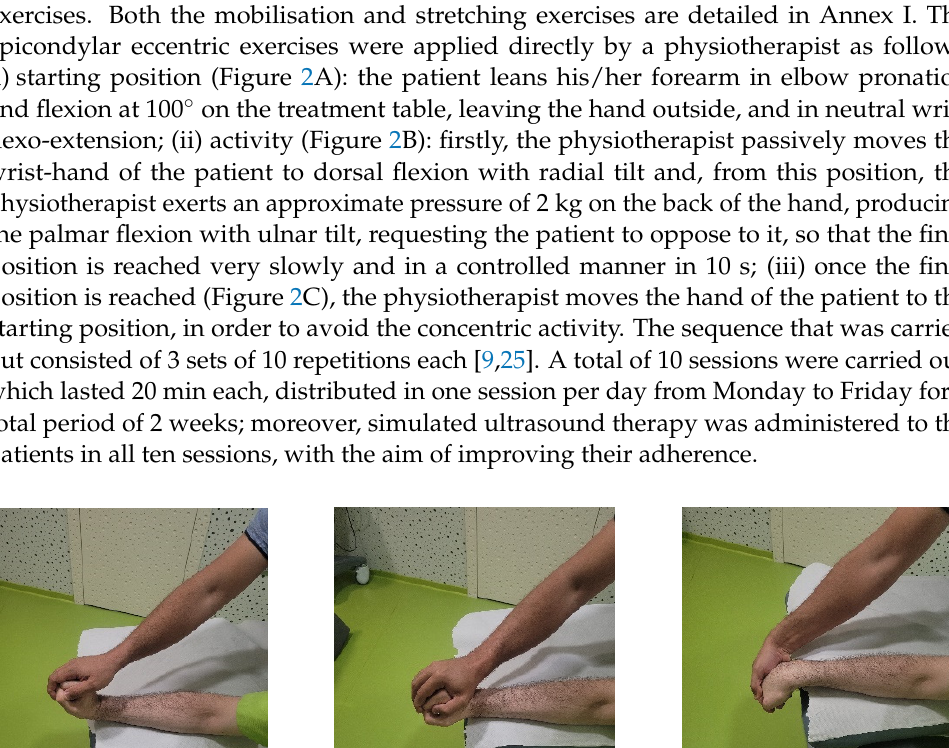
( C ) Figure 3. Patient in the control group performing the exercise using the elastic band: ( A ) starting position; ( B ) intermediate position; ( C ) final position. 2.7. Statistical Analysis Descriptive statistics were calculated for all outcome measures, including measure- ments of central tendency and dispersion. Qualitative outcomes were described as num-